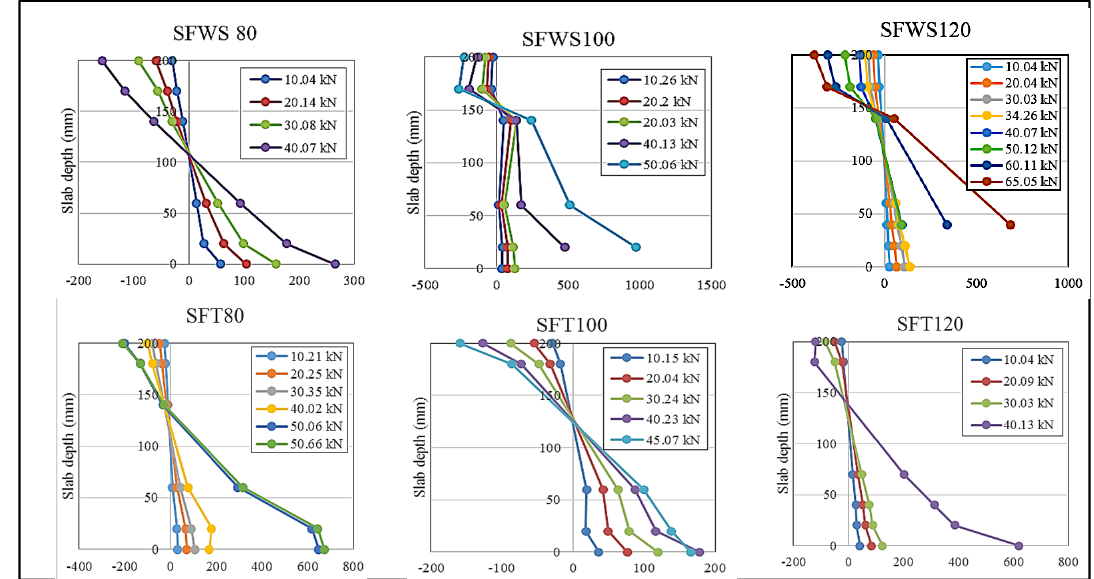
Figure 4. Strain distribution of SFWS and SFT samples.